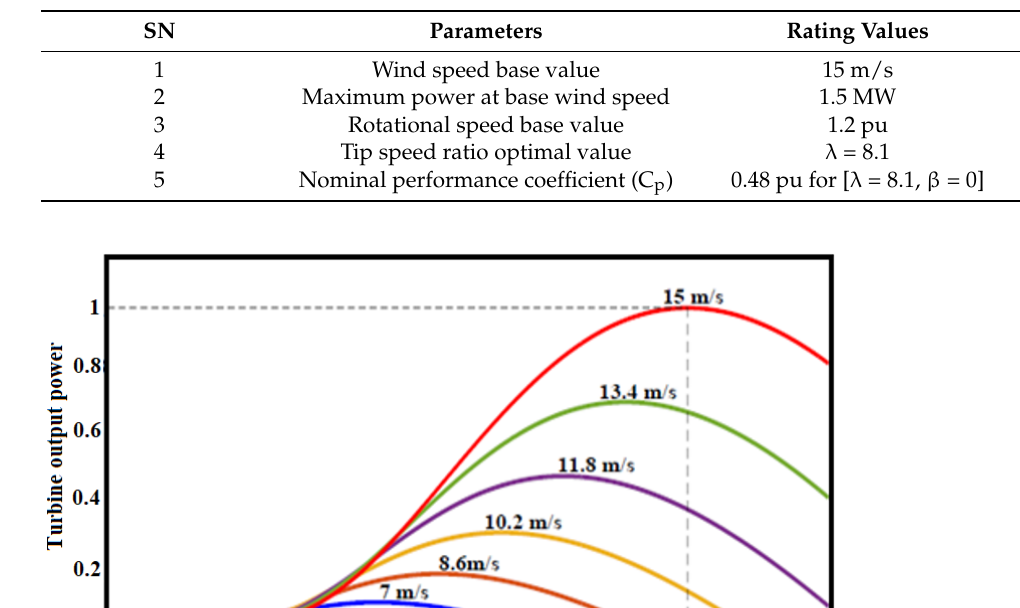
Table 2. Design specifications for the wind system.